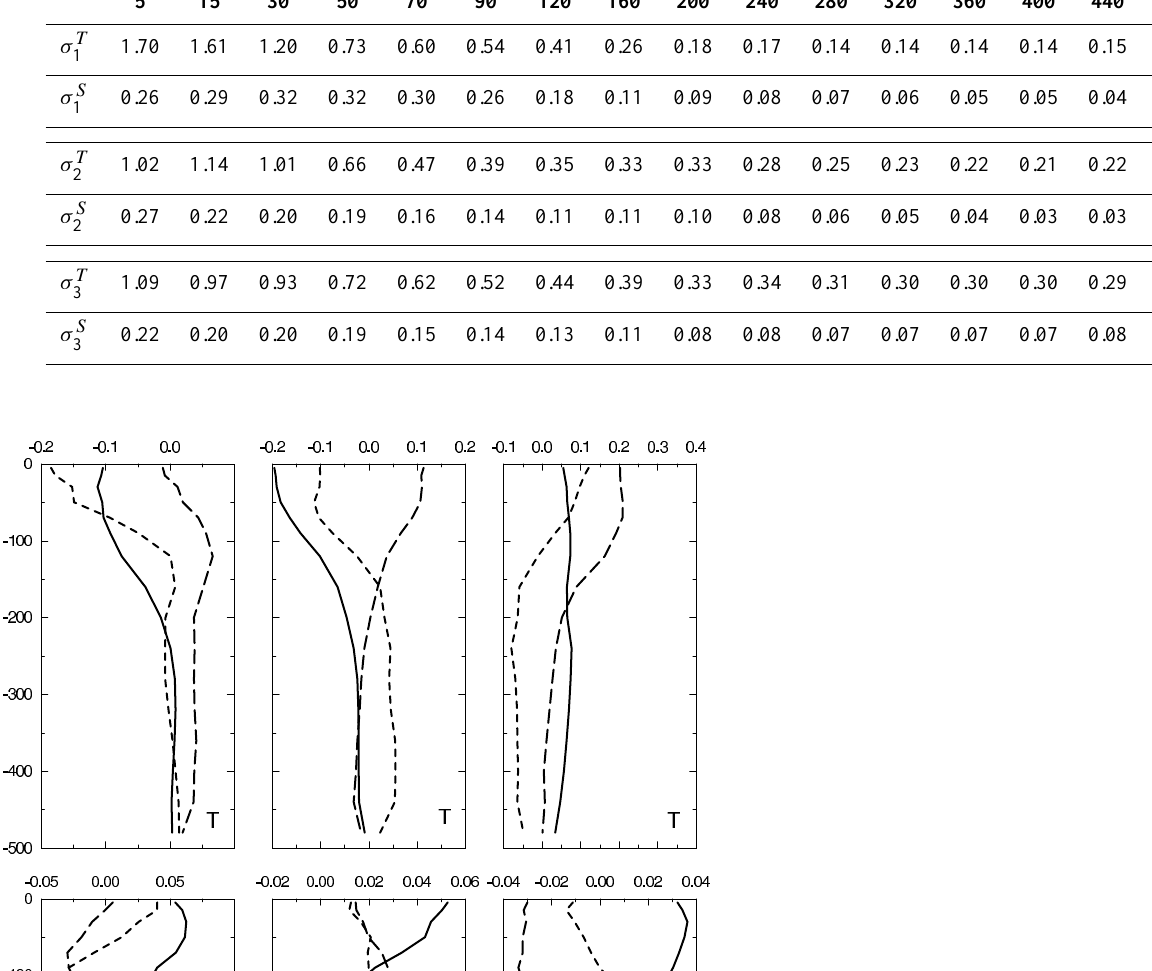
Fig. 3. Bivariate Empirical Orthogonal Functions used in assimilation of XBT in (a) Algerian Basin, (b) Tyrrhenian Sea and (c) Ionian Sea. The continu- ous line shows the first EOF, the long dashed line the second EOF and the short dash line, the third EOF. The tem- perature EOFs are present in the upper panels and salinity EOFs in the bottom